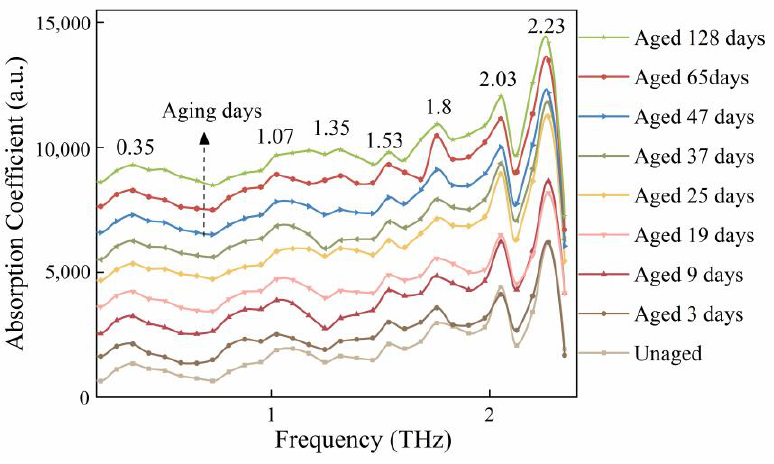
Figure 3. Absorption spectra of the insulating paper with different aging days.